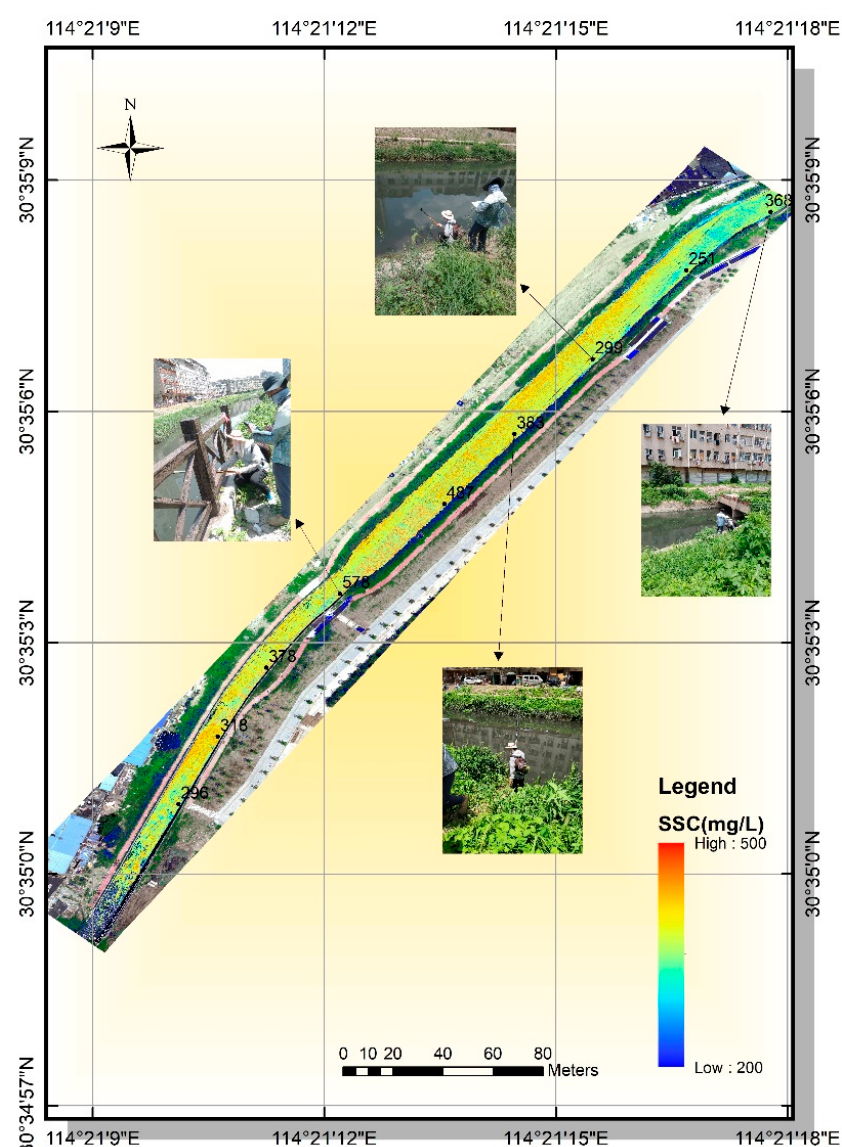
Figure 14. Inversion results of SSC for the UAV-borne HRS images for the SP dataset.